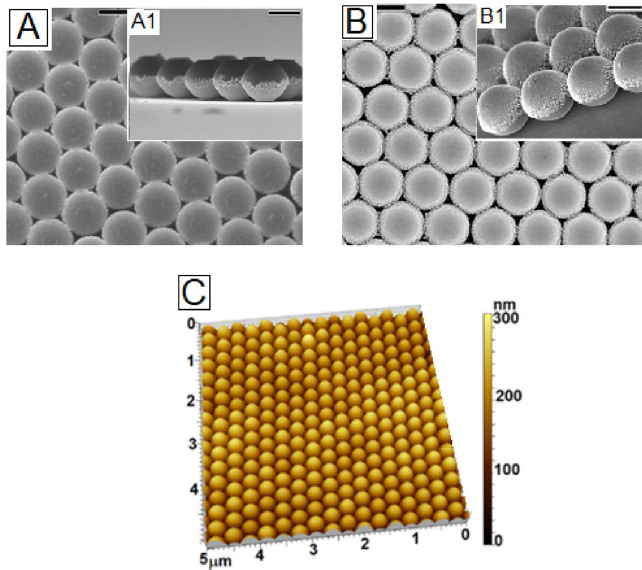
Figure 3. Top-view FESEM image of the spin coated Janus particles (dia 300 nm) on ( A ) gold coated silicon wafer (hydrophilic) and ( B ) silanized silicon wafer (hydrophopic). Insets A1 and B1 show the respective tilted images, which capture the orientationof the particles. ( C ) AFM image corresponding to the FESEM image shown in frame